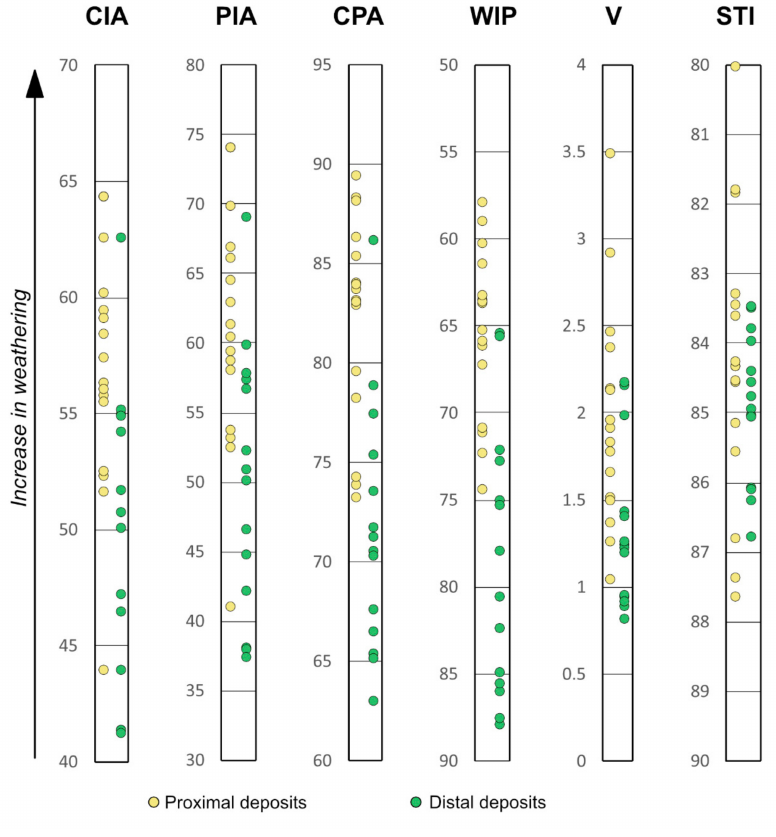
Figure 10. Conventional weathering indices for the mudstone samples. The weathering indices were formulated as molar calculation of some major elements: CIA = [Al 2 O 3 / (Al 2 O 3 + CaO + Na 2 O + K 2 O)] / (Al + CaO + Na / (Al + Na × 100; PIA = (Al × 100; CPA = Al × 100; 2 O 3 – K 2 O) 2 O 3 2 O – K 2 O) 2 O 3 2 O 3 2 O) WIP = (2Na 2 O / 0.35 + MgO / 0.9 + 2K 2 O / 0.25 + CaO / 0.7) × 100; V = (Al 2 O 3 + K 2 O) / (MgO + CaO + Na 2 O); and STI = (SiO 2 / TiO 2 ) / [(SiO 2 / TiO 2 ) + (SiO 2 / Al 2 O 3 )] + (Al 2 O 3 / TiO 2 )] × 100. In most of the weathering indices, except for the STI index, the distal deposits indicate lower degree of chemical weathering in compared to the proximal